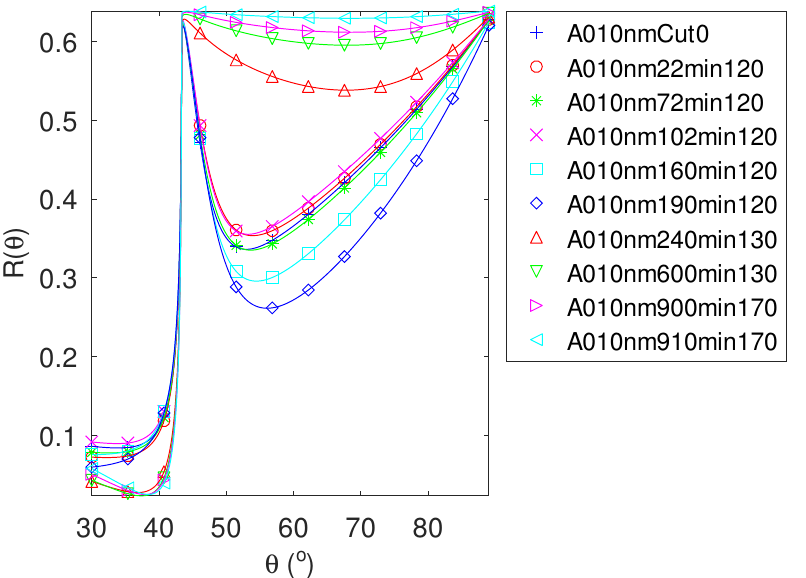
Figure 2. Simulated SPR setup signal for the samples of initial target thickness 10 nm. The calculation uses the parameters deduced from the fitting of UV-visible-NIR absorbance curves. The optical properties of copper and copper oxide are calculated at wavelength λ 0 = 632.8 nm. Upper medium is air.